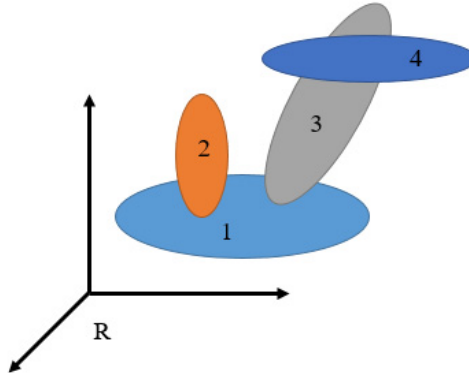
Figure 1. Multi-body system diagram of grinding machine.